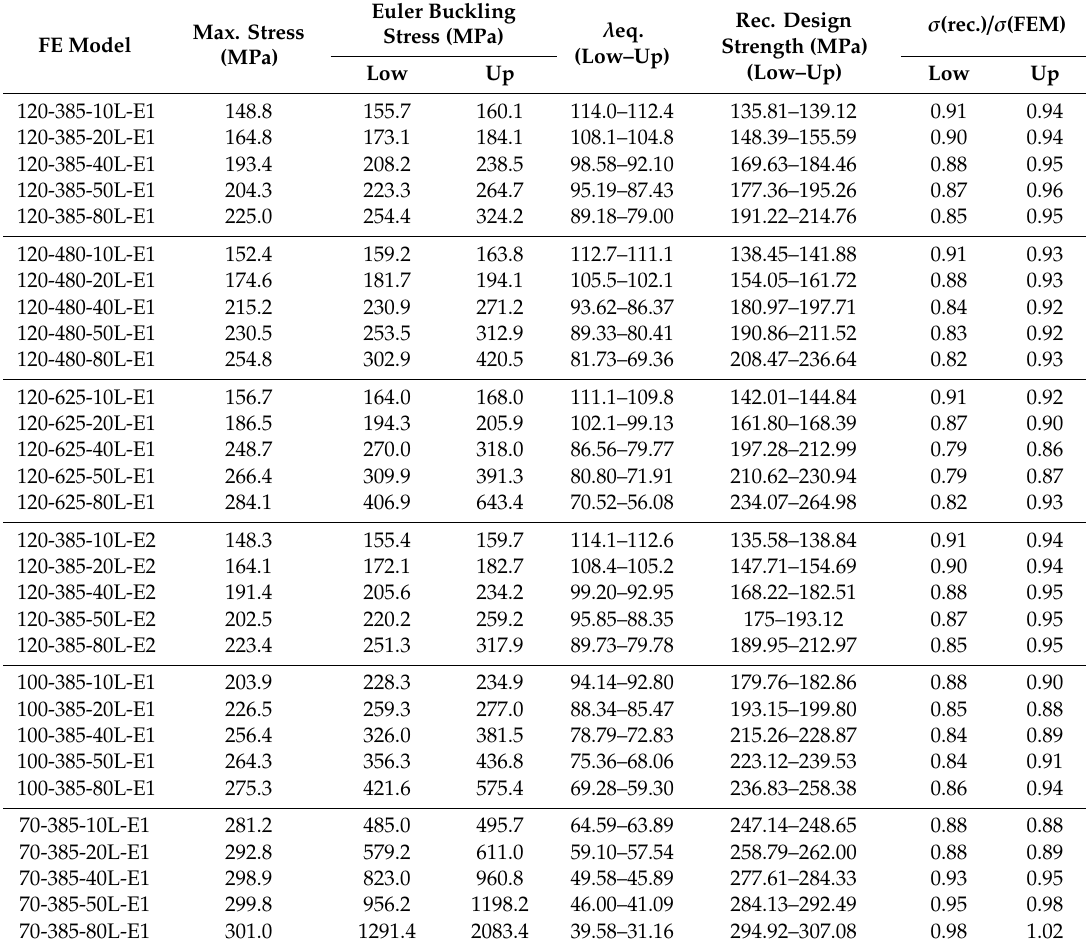
Table 4. Strength recommendation for strengthened